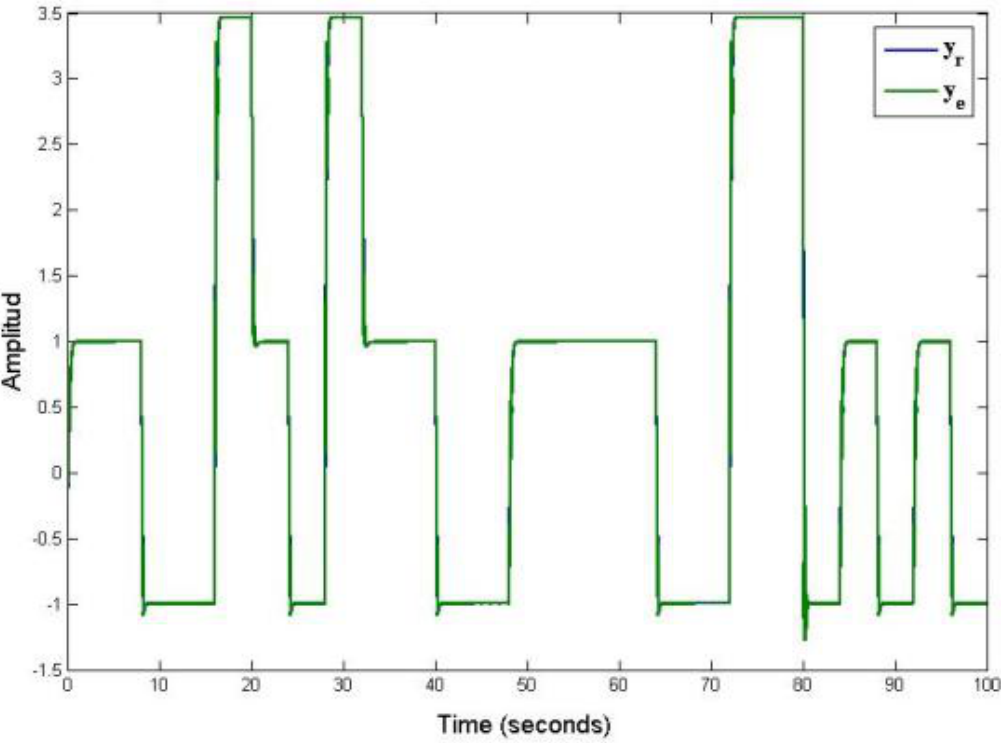
Figure 3. Output of the observer in piecewise a linear system, unknown and arbitrary commutation